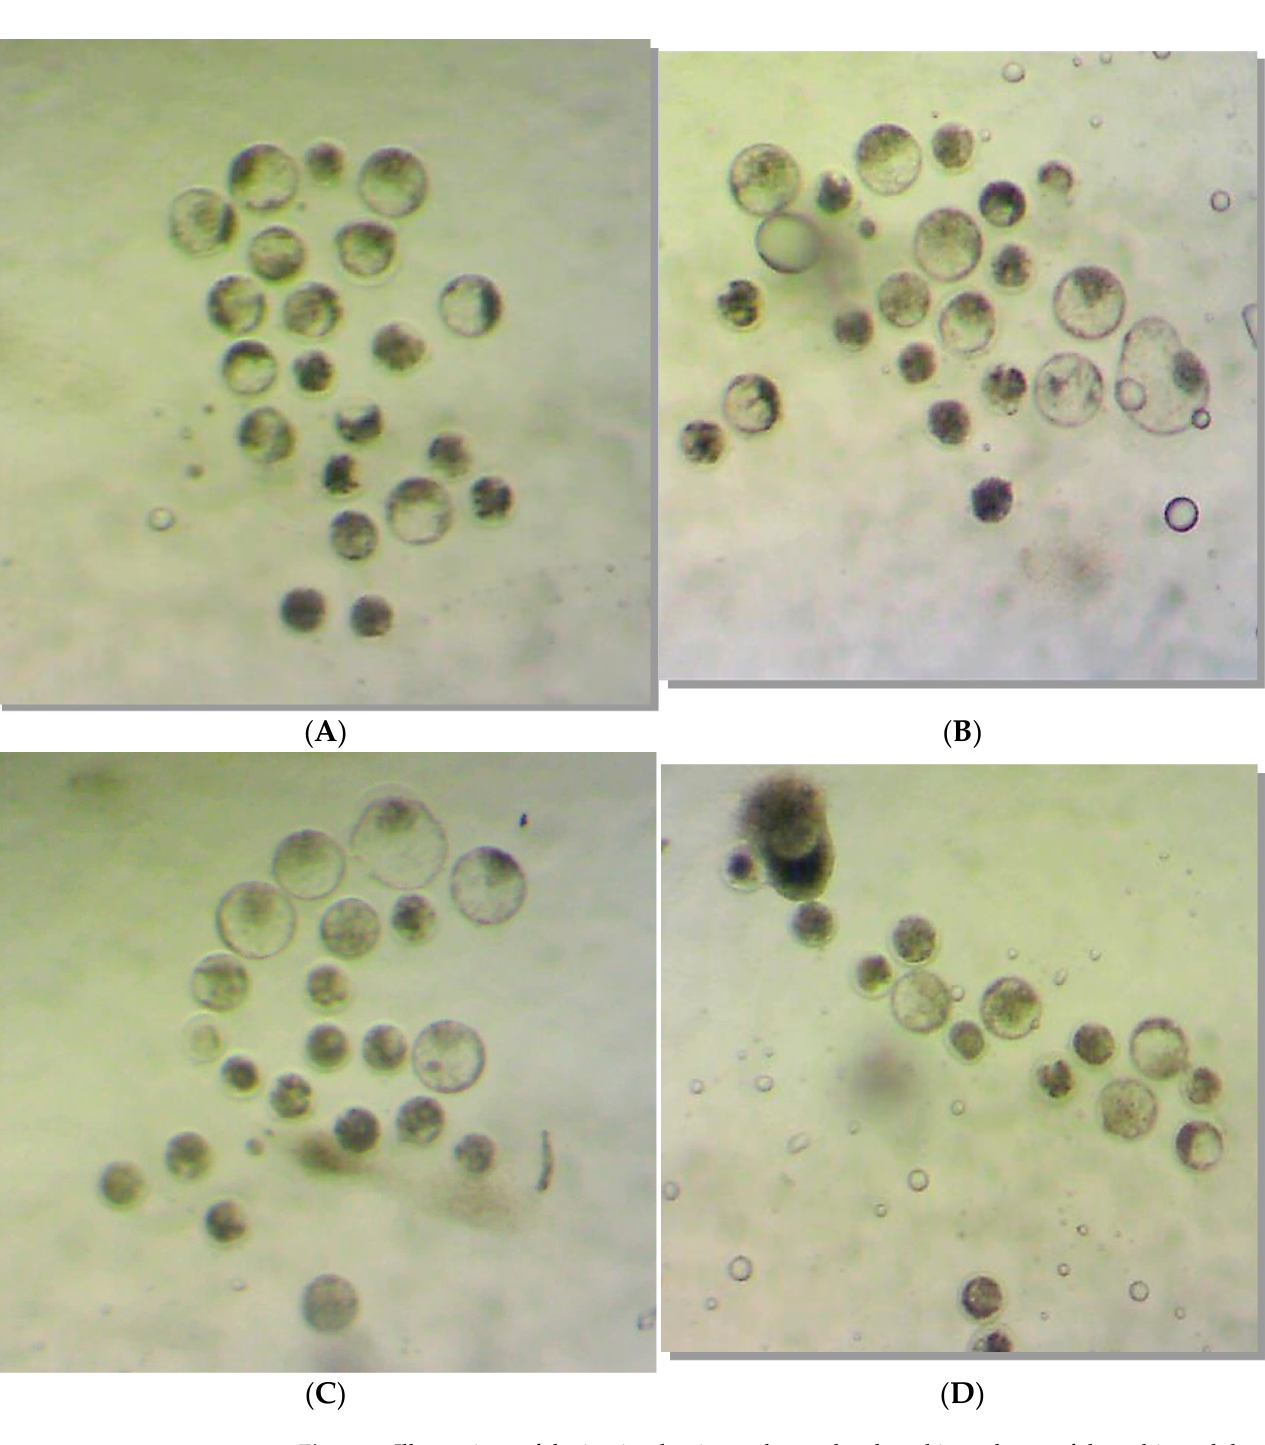
Figure 2. Illustrations of the in vitro bovine embryos developed in each one of the cultivated drops (Experiment 2/IVP Replicate 2.1) for each treatment group: ( A ) Group 1, ( B ) Group 2, ( C ) Group 3, and ( D ) Group 4. The size difference observed between the structures is due to the enlargement/reduction of the photo depending on the number of embryonic structures present in each photo. The objective here is to illustrate the morphological characteristics and degrees of the embryos obtained.